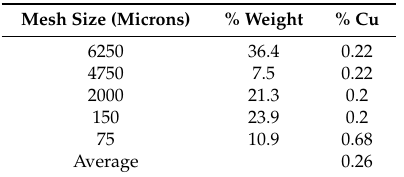
Table 2. Particle size distribution and particle